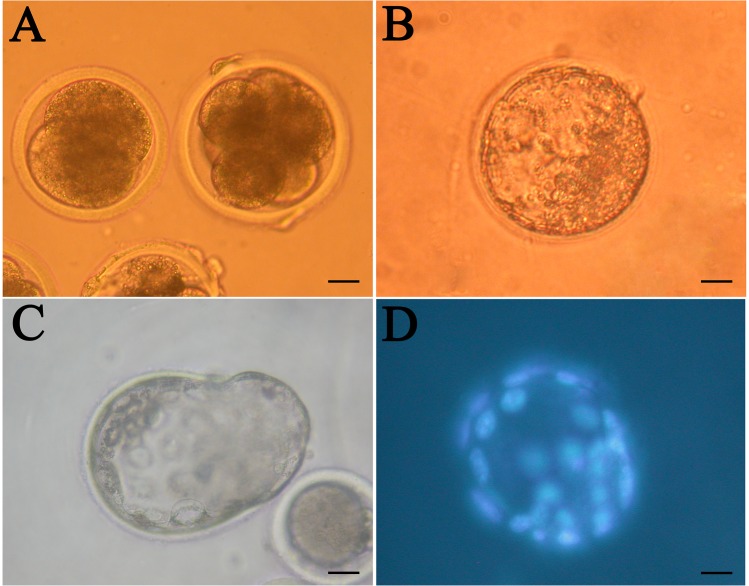

In Vitro Cultured Cloned Sheep Embryos.A, 2- and 8-cell embryos; B, early blastocyst; C, hatching blastocyst; D, early blastocyst stained with Hoechst 33342. Scale bar: 20 μm.